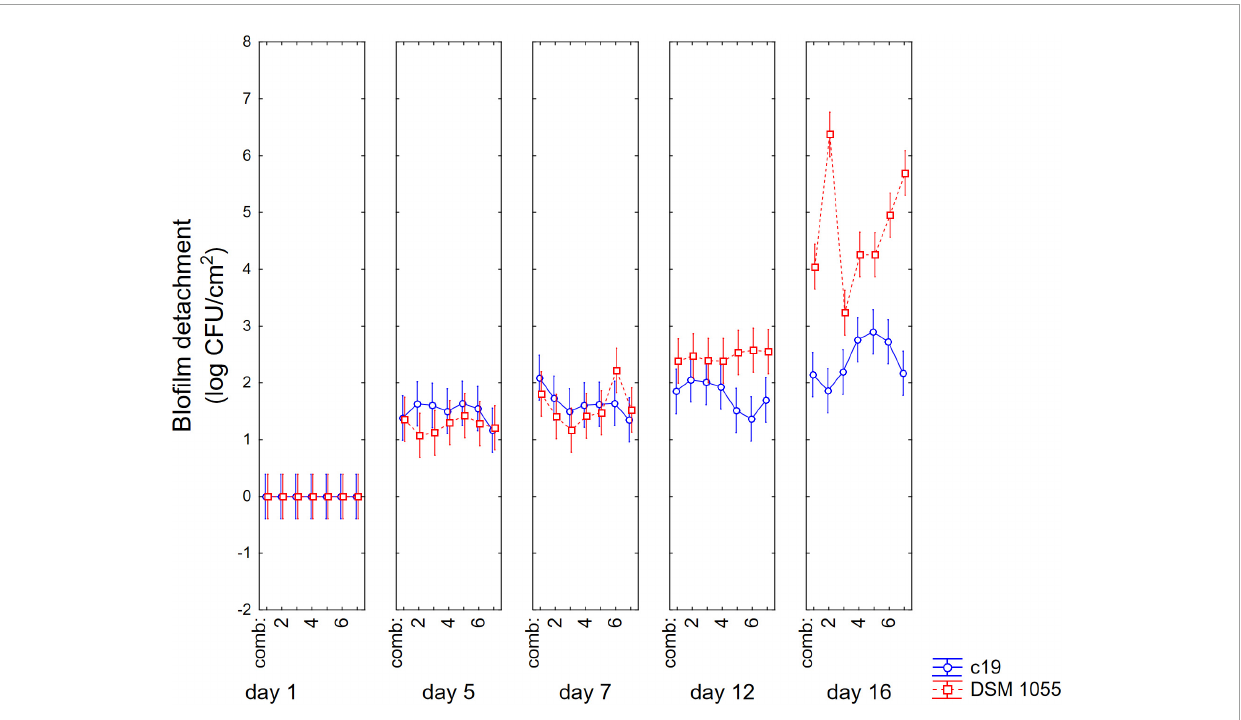
FIGURE6 Decomposition of statistical hypothesis related to the interactive term “strain × biofilm age × US treatment” on the detachment of biofilm (log CFU/cm 2 ) of L. plantarum c19 and DSM 1055. Mean values ± 95% confidence interval.